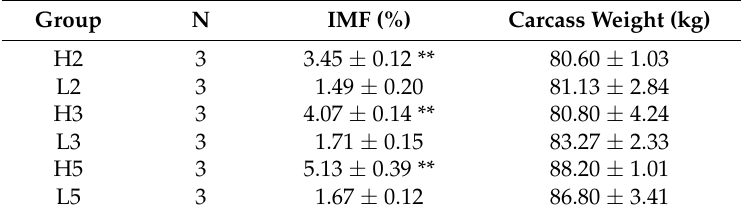
Table 1. Summary statistics of intramuscular fat (IMF) content in the tested